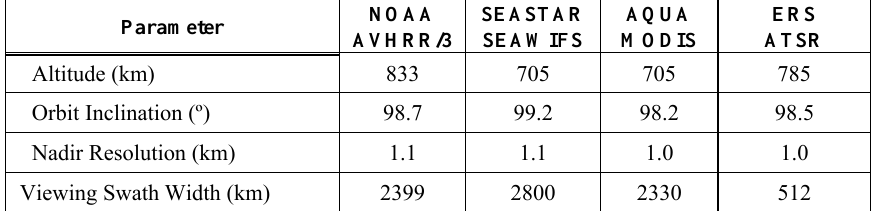
NOAA SEASTAR AQUA ERS AVHRR/3 SEAWIFS MODIS ATSR